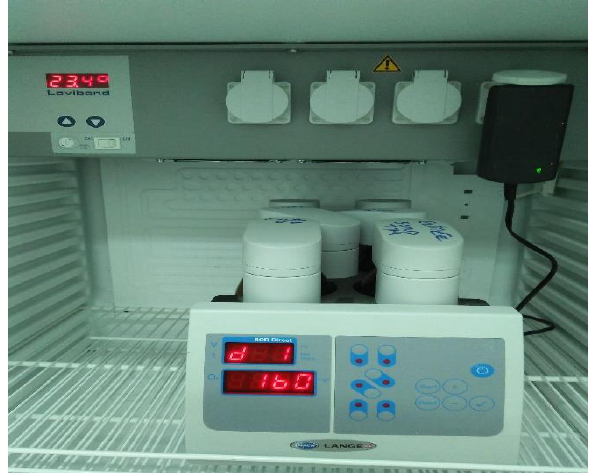
Illustration 1. Biochemical oxygen demand (BOD5)